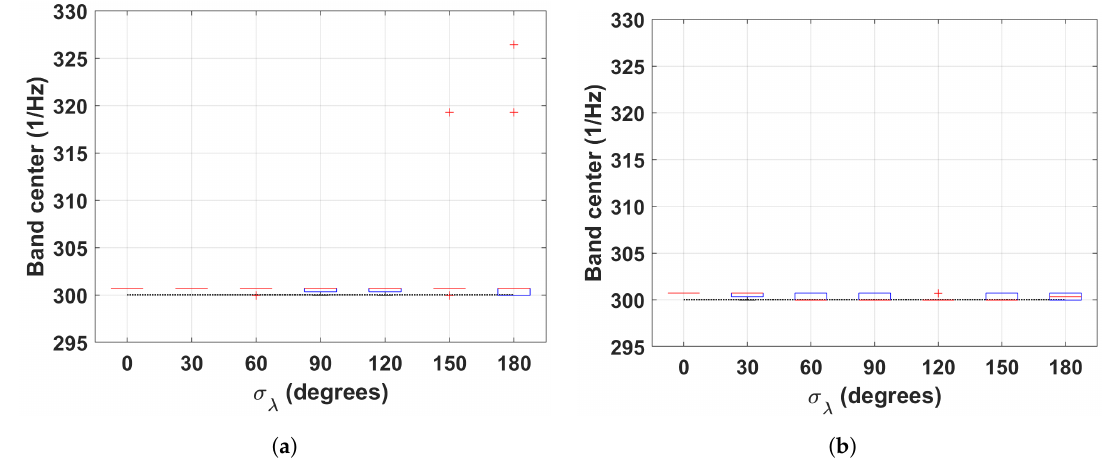
Figure 4. Results summary of the f − AFM algorithm. Notice that the median highest energy spectral density HESD (red lines) closely follow the period of the simulated signals (dahsed lines). ( a ) Squared signal. ( b ) Sinusoidal